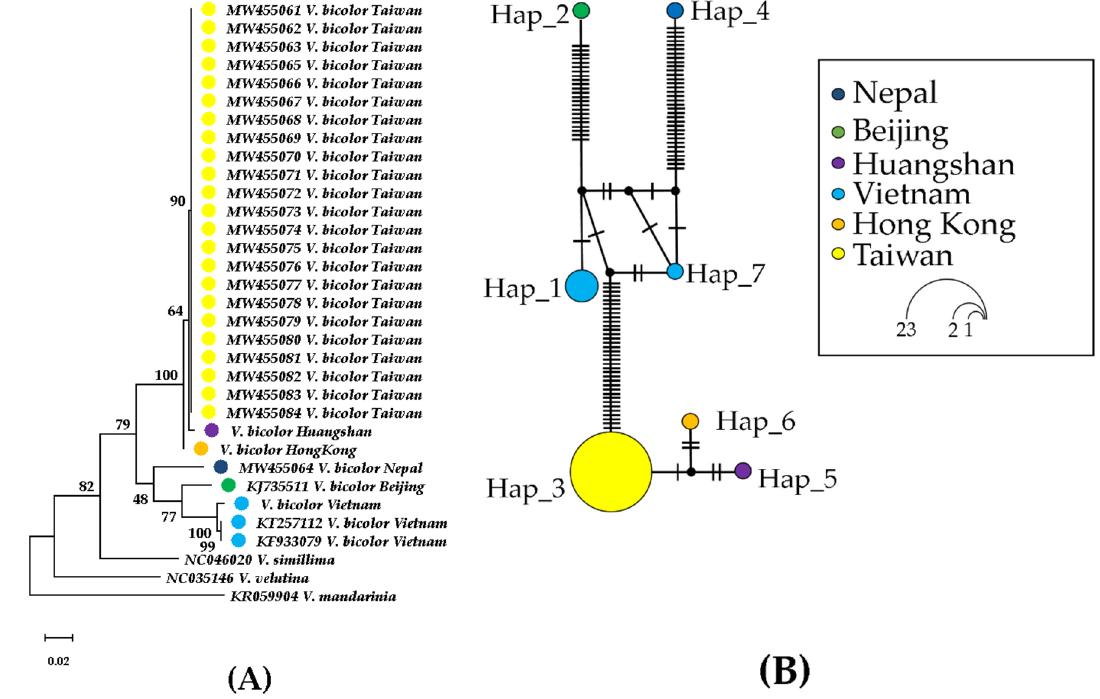
Figure 2. Phylogenetic tree and haplotype network of V. bicolor from China, Hong Kong, Nepal, Taiwan, and Vietnam. ( A ) Phylogenetic tree computed on COI sequences. Each number on the branch represents node stats in maximum likelihood bootstrap values. ( B ) Haplotype network. Each bar on the branch represents a single nucleotide substitution. Circle size is equivalent to sample size. Median vectors are represented by black circles.